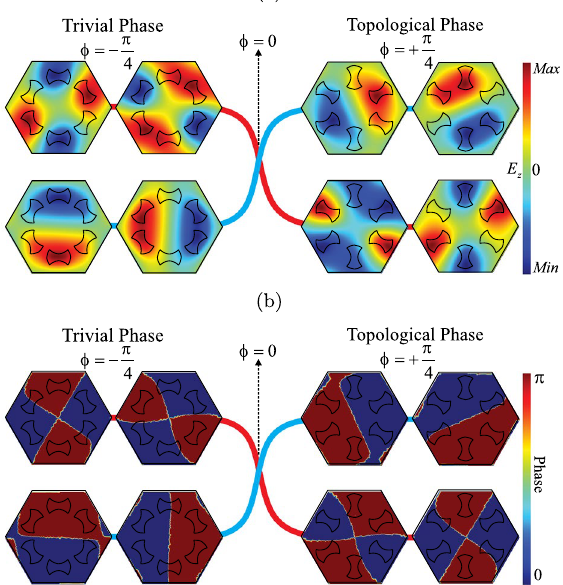
π/ 4 and φ π/ 4 . ( a ) Electric = − = π/ 4 the frequency of the dipole modes is ≤